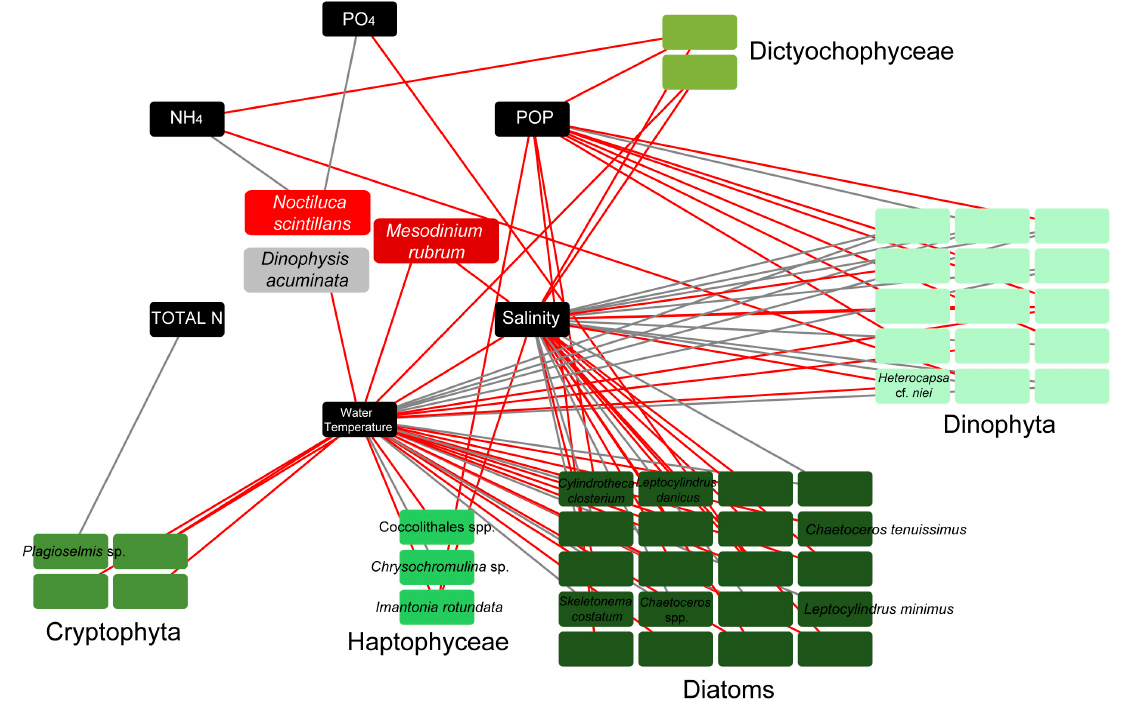
Figure 4. Network diagrams of highly significant connections ( p -values < 0.01) based on the maximal information coefficient (MIC) scores between dominant taxa (comprising of > 10% of the total plankton abundance in at least one sample) and environmental parameters. Boxes (nodes) with indicated taxa names, represent bloom (detected with abundances > 1000 cells mL − 1 in at least one sample throughout the samplings), and red tide forming taxa. To facilitate reading only bloom and red tide forming taxa are indicated. Black lines (edges) depict positive connections, and red edges depict negative connections.